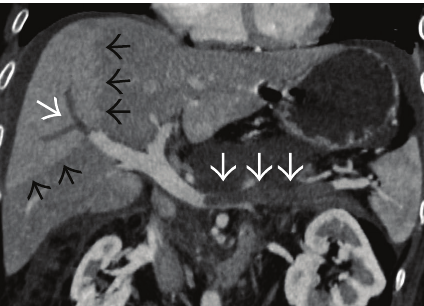
Figure 37: Coronal oblique CECT image of a patient with acute necrotizing pancreatitis demonstrates thrombosed splenic vein (thick white arrows) and a segmental branch of right portal vein (thin white arrow) with hepatic artery buffer response in the form of differential hyperenhancement of the affected liver segment (black arrows).